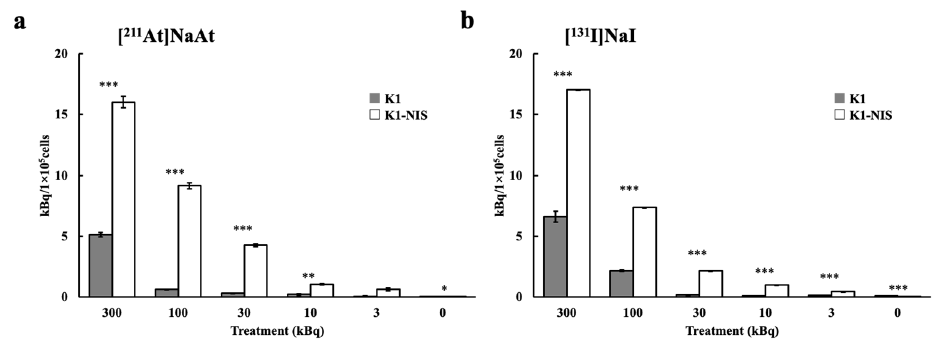
Figure 3. Uptake of K1 or K1 ‐ NIS cells treated with [ 211 I]NaAt ( a ) and [ 131 I]NaI ( b ) solutions. Data was shown in mean ± S.E. p ‐ value: *** p < 0.001, ** p < 0.01. * p < 0.05.